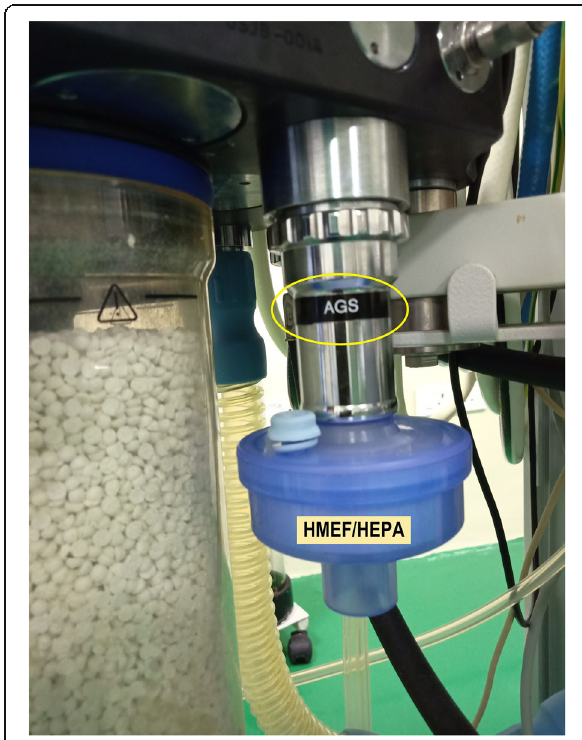
Fig. 1 Drager Fabius Plus anesthesia workstation — the heat moisture exchanger bacterial-viral filter (HMEF) is attached to the active gas scavenging (AGS) port (labeled on the machine by the manufacturer). HEPA, high-efficiency particulate air